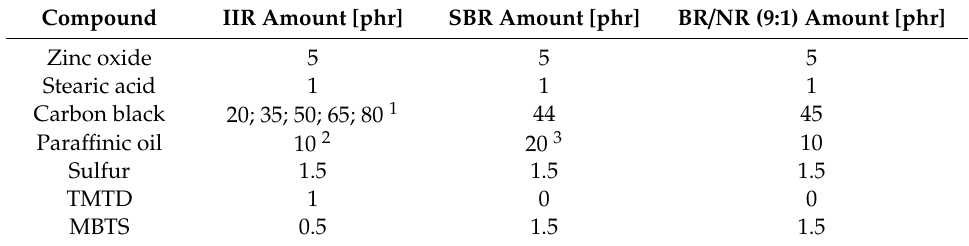
Table 1. Composition of rubber formulations for butyl rubber (IIR), styrene–butadiene rubber (SBR) and butadiene rubber (BR) / natural rubber (NR). (TMTD, tetramethylenethiuram disulfide; MBTS, mercaptobenzothiazole disulfide).